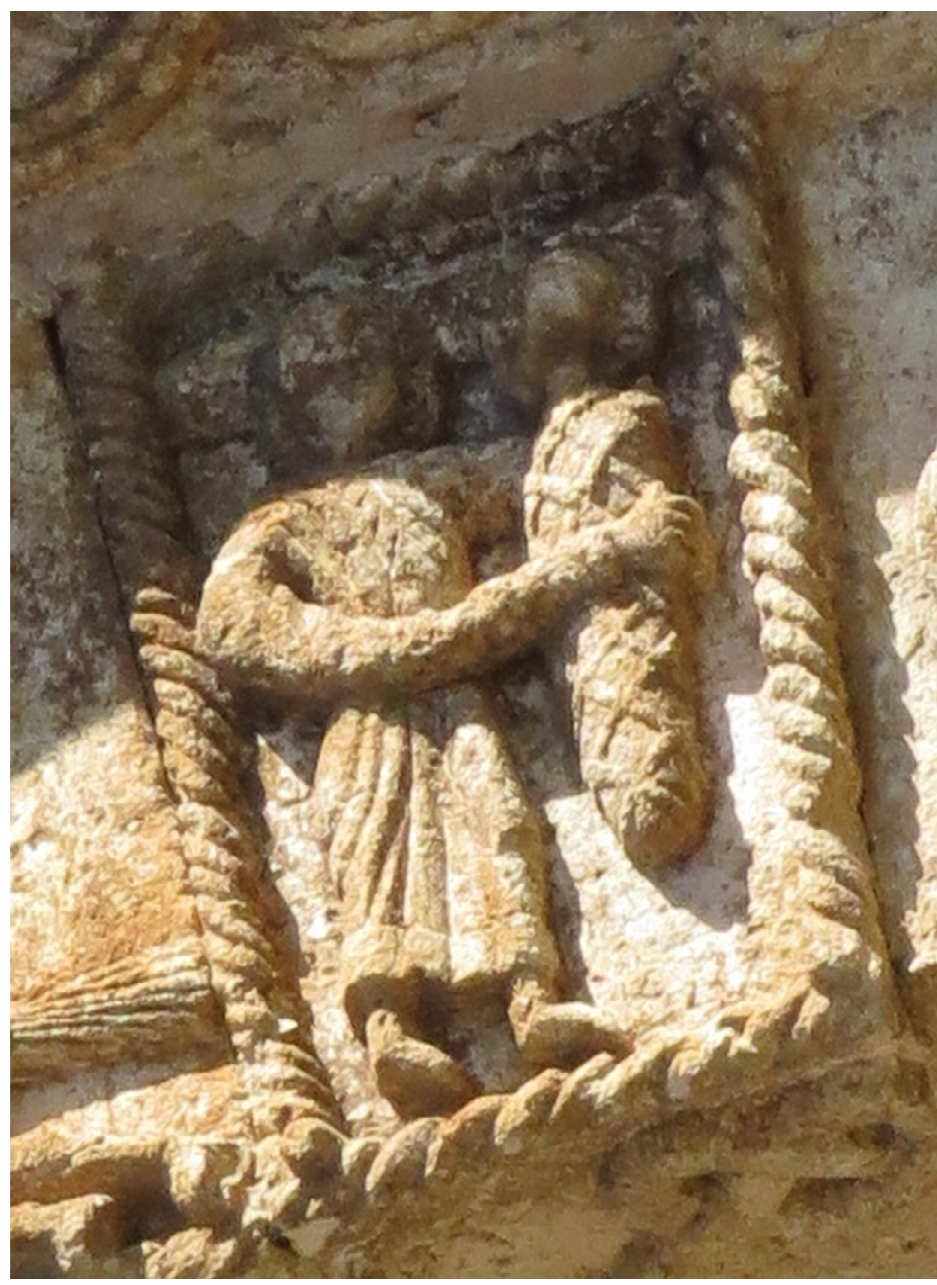
Figure 8. Virgin and Child or Abraham and Lazarus, and rope pattern detail of archivolt, west façade, Saint-Martin Church , 12th c., Besse, Dordogne, Nouvelle-Aquitaine, France. ©Author.